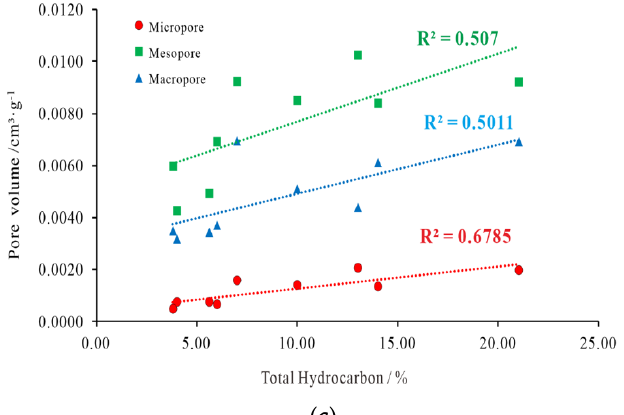
Figure 11. Cross plot of total hydrocarbon, clay minerals, specific surface area and pore volume. ( a ) Relationship between Clay mineral content and Total Hydrocarbon; ( b ) Relationship between pore-specific surface area and Total Hydrocarbon; ( c ) Relationship between pore volume and Total